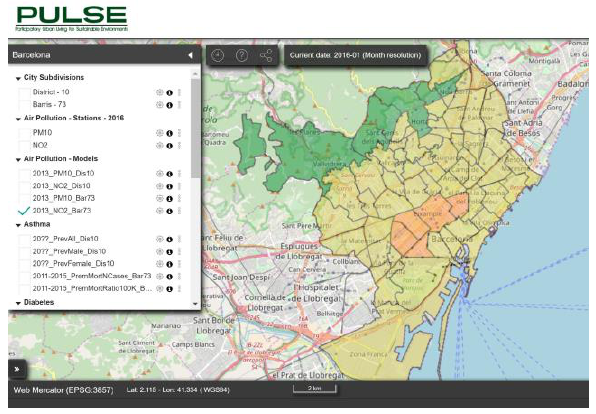
Figure 1. screenshot of the PULSE WebGIS page related to the city of Barcelona. This map, made partially transparent, shows the average quantity of NO2 measured in the different neighborhoods of the city in the year 2013 For example, considering the hospitalization rate of a certain disease, this rate can change depending on the considered hospital or on the zipcode where the patients live, depending on specific risk factors that can have differences within the city themselves. Spatial Enablement is one of the fundamental paradigms in PULSE, and it has been explored and applied in different systems, both for representation and analysis